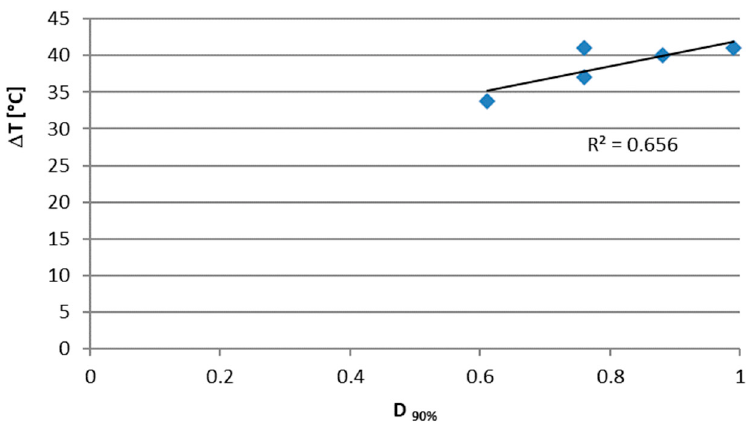
Figure 12. Relationship between the maximum temperature increase and the damage index at 90% of the fatigue life.